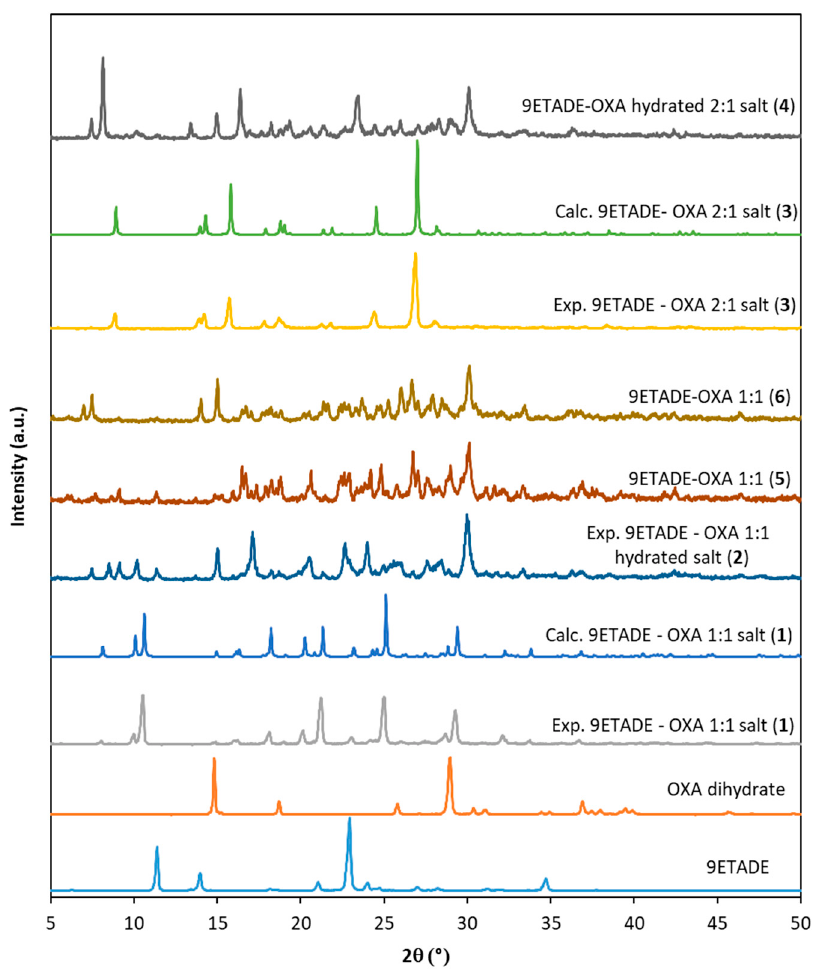
Figure 1. Comparison of the experimental and calculated powder patterns of 9ETADE, oxalic acid dihydrate and the as-synthesized compounds 1 – 6 .